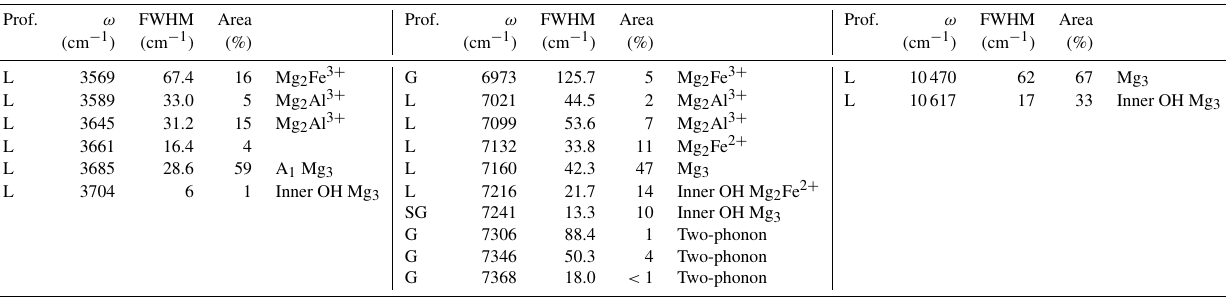
Table 3. Profile function (prof.), frequency ( ω ), full width at half maximum (FWHM) and relative area of bands related to structural OH groups in the MIR and NIR spectra of lizardite. Proposed assignments are also indicated in terms of cationic environments or contribution to the two-phonon continuum (two-phonon). Unless specified, they correspond to inter-layer OH groups. Prof. ω FWHM Area Prof. ω FWHM Area Prof. ω FWHM Area (cm − 1 ) (cm − 1 ) (%) (cm − 1 ) (cm − 1 ) (%) (cm − 1 ) (cm − 1 ) (%) L 3569 67.4 16 Mg 2 Fe 3 +